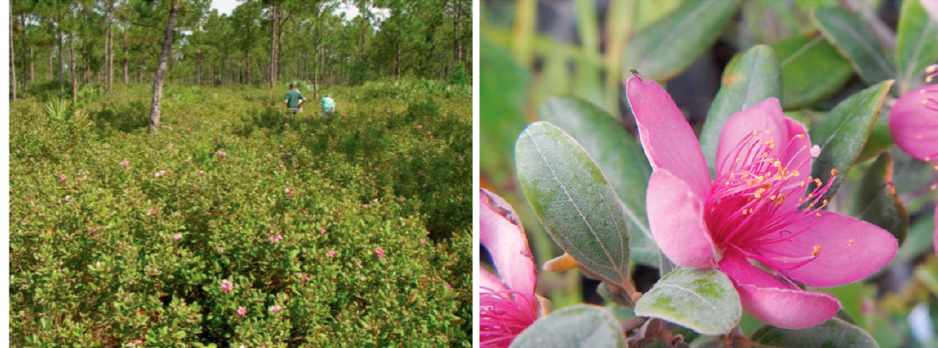
Figure 1. Rhodomyrtus tomentosa infestation in Palm Beach County, Florida, USA (left) and a close-up of the attractive flower from which is derives the common name, downy rose myrtle (right) (photos: M.C. Smith).